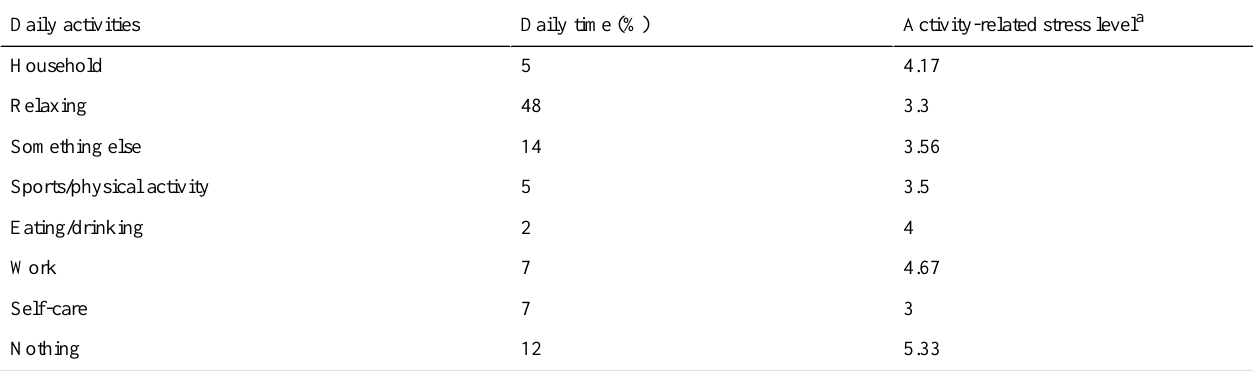
Table 6. Person 3: daily activities and levels of activity-related